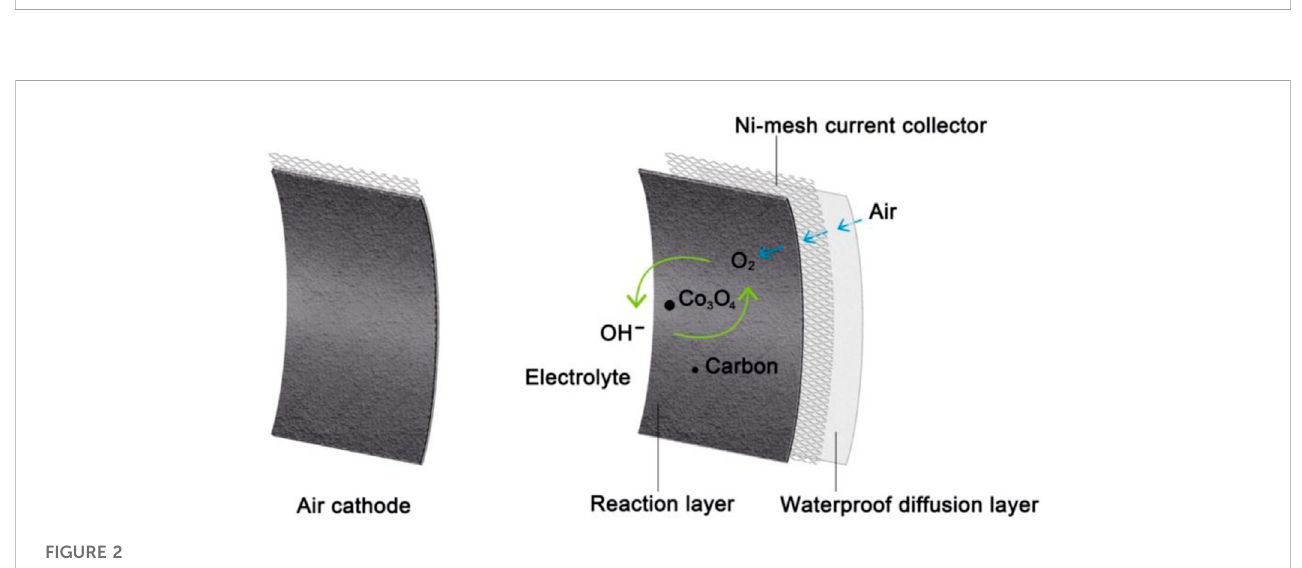
FIGURE 1 Schematic diagram of the mold of ZAB. (A) Schematic diagram of the assembled ZAB, (B) Exploded diagram of each ZAB ’ s component.